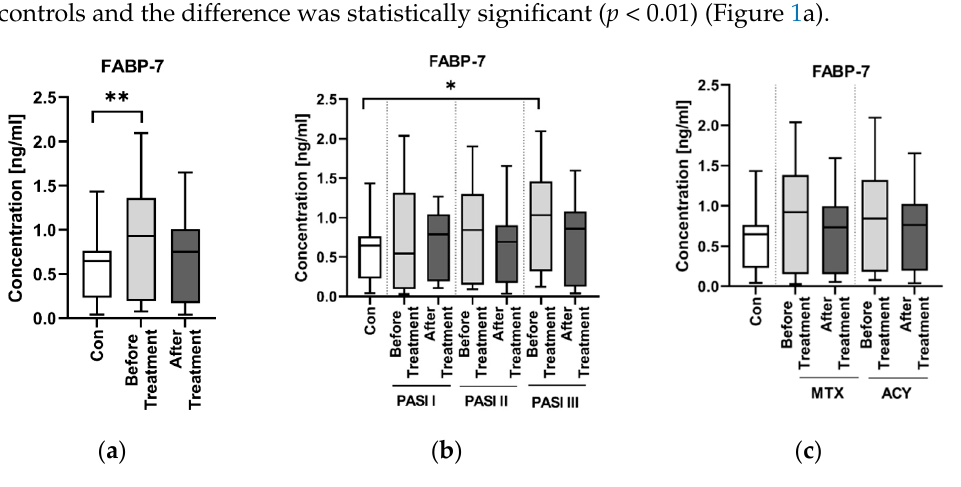
Figure 1. Concentration of FABP-7 in patients (before and after the treatments) and controls ( a ); Concentrations of FABP-7 in patients (before and after the treatment) according to PASI division, as well as in controls ( b ); FABP-7 concentrations in patients (before and after the treatment with methotrexate, MTX, or acitretin, ACY) and controls ( c ). ** means statistically significant difference with p < 0.01. * means statistically significant difference with p < 0.05.